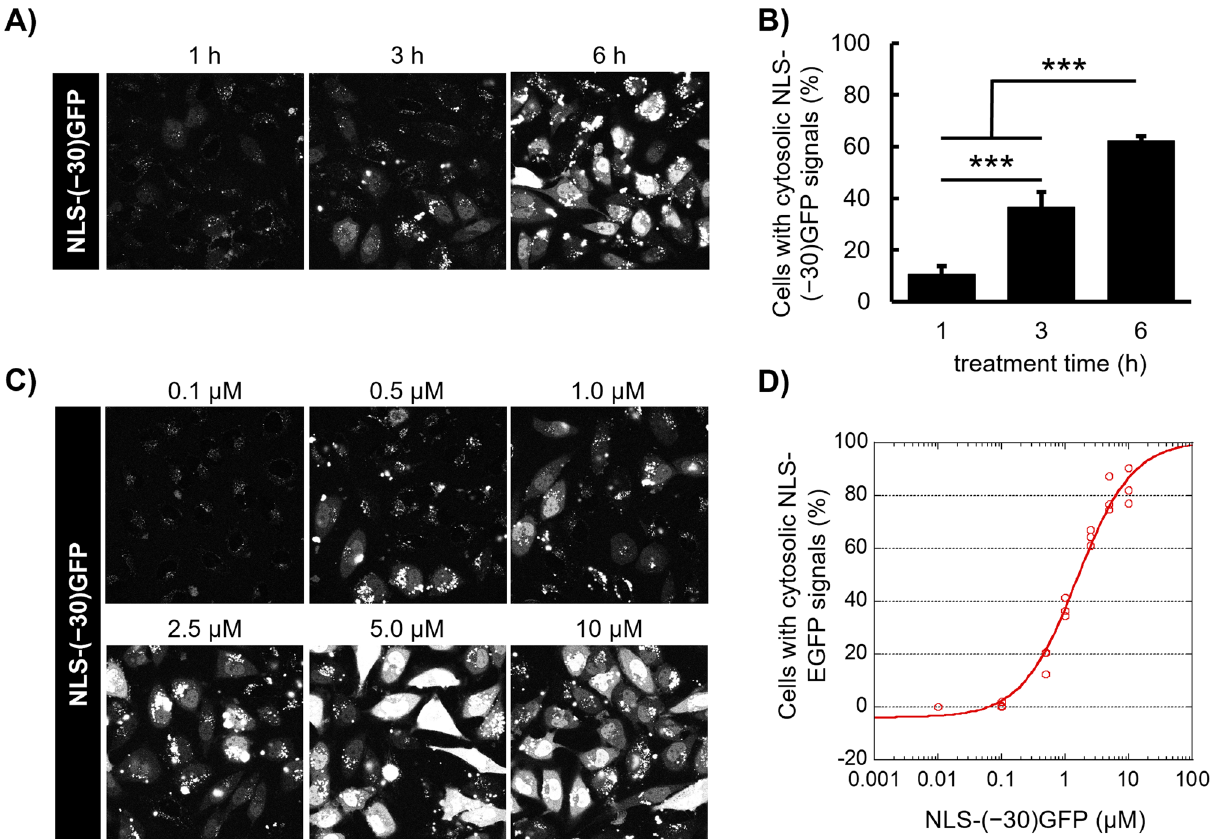
Figure 5. Time- and concentration-dependence of the cytosolic delivery of NLS-(− 30)GFP-LNPs. ( A ) CLSM observation of the cytosolic appearance of NLS-(− 30)GFP after treatment with NLS-(− 30)GFP-LNPs (1:10) (equivalent to 2.5 μM NLS-(− 30)GFP) for 1, 3, and 6 h. ( C ) CLSM observation of the cytosolic appearance of NLS-(− 30)GFP after treatment with NLS-(− 30)GFP-LNP (1:10) (NLS-(− 30)GFP concentration = 0.1, 0.5, 1.0, 2.5, 5.0 or 10 μM) for 6 h. ( B , D ) Percentages of cells bearing cytosolic NLS-(− 30)GFP signals. Results are presented as mean ± SD (n = 3). *** P < 0.001 (ANOVA followed by Tukey–Kramer’s honestly-significant difference test for ( B